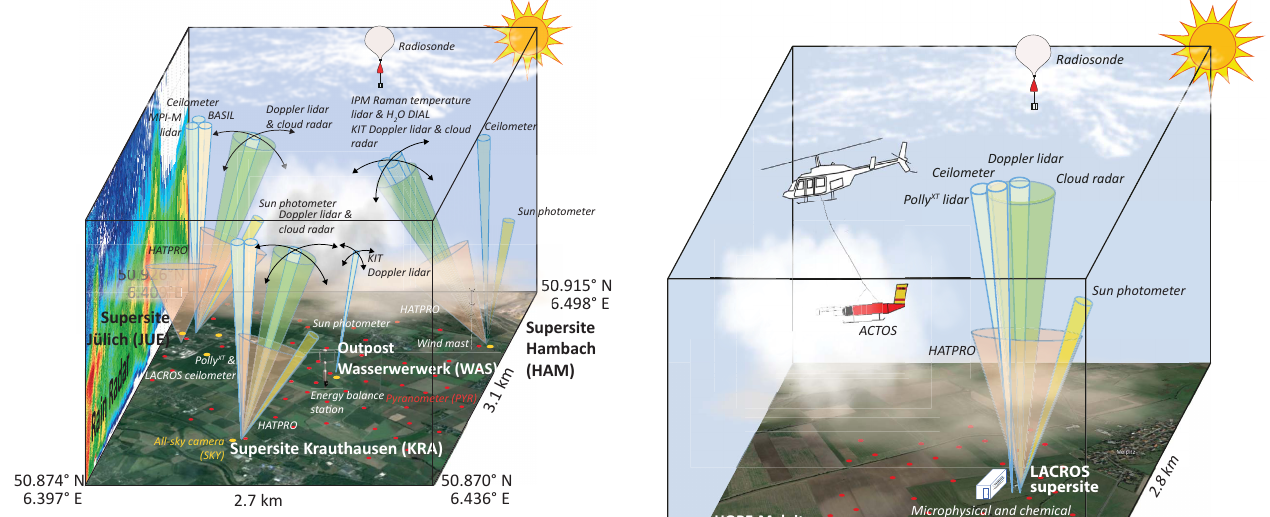
Figure 1. Set-up of the HOPE-Jülich campaign showing the lo- cation of the three supersites Jülich (JUE), Hambach (HAM), and Krauthausen (KRA) as well as the outpost Wasserwerk (WAS) with their main instrumentation. The cones and arrows illustrate the field of view and scanning capabilities of the specific remote-sensing in- struments.